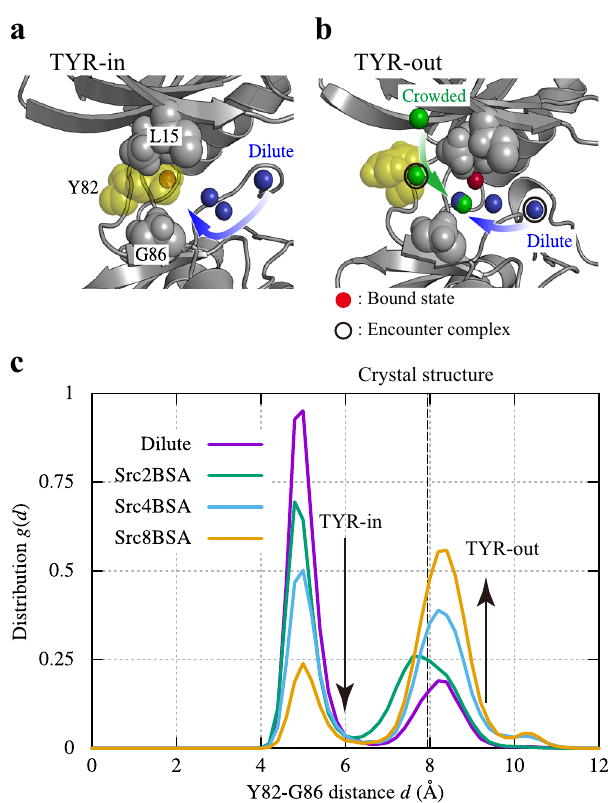
Fig. 5 Distribution of the TYR-in and TYR-out states of c-Src kinase. a TYR-in state structure together with a binding trajectory in the dilute solution. b TYR-out state structure with binding trajectory in the dilute and crowded solution (Src8BSA). Red, blue, and green spheres represent the PP1 bound position in the crystal structure, representative binding pathways in dilute and crowded solutions, respectively. Encounter states in the pathways are circled. c Distribution for Tyr82-Gly86 distance, g ( d ). The distance between Tyr82 and Gly86 in a crystal structure of c-Src kinase in a complex with an inhibitor (ID: 1Y57) is shown with dashed line for comparison 68